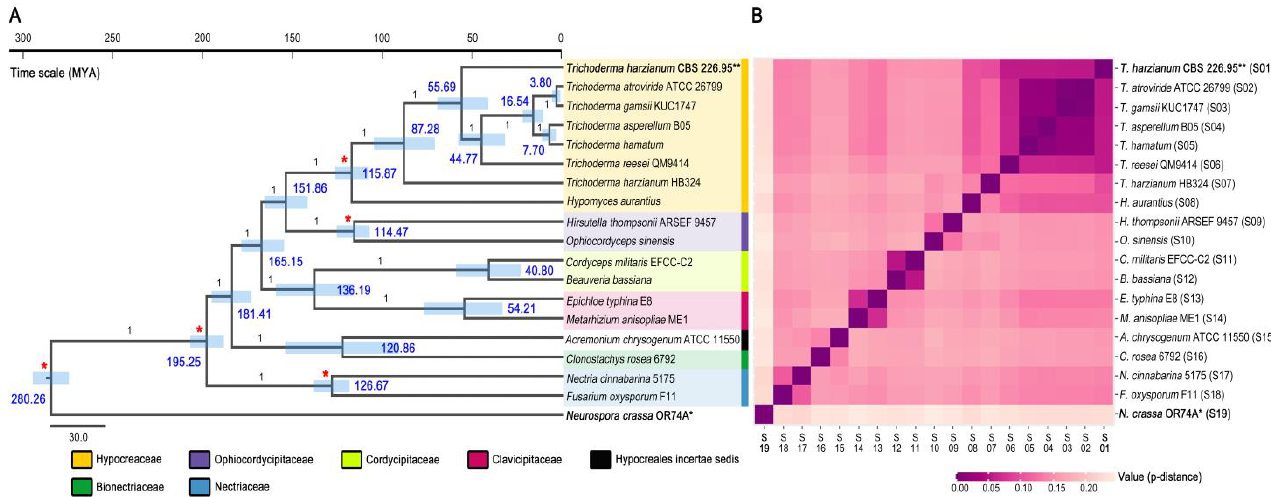
Figure 4. Comparative analysis of Trichoderma mitogenomes — II. ( A ) Time-scaled Bayesian tree on Trichoderma mitogenomes that includes a new isolate of Trichoderma . Estimated chronological times were presented in time scale in the time scale of Mya (million years ago), with 95% confidence interval values in blue bars. Bayesian posterior probabilities (BPPs) values and calibration points were indicated at nodes using numbers (black) and asterisks (red), respectively. ( B ) Pairwise genetic distance among Hypocreales mitogenomes. All used fungal species (including N. crassa OR74A as an outgroup) and obtained p-distance values are described in Tables S5 and S10, respectively. Asterisks for the Neurospora crassa OR74A mitogenome (*) and T. harzianum CBS 226.95 mitogenome (**).